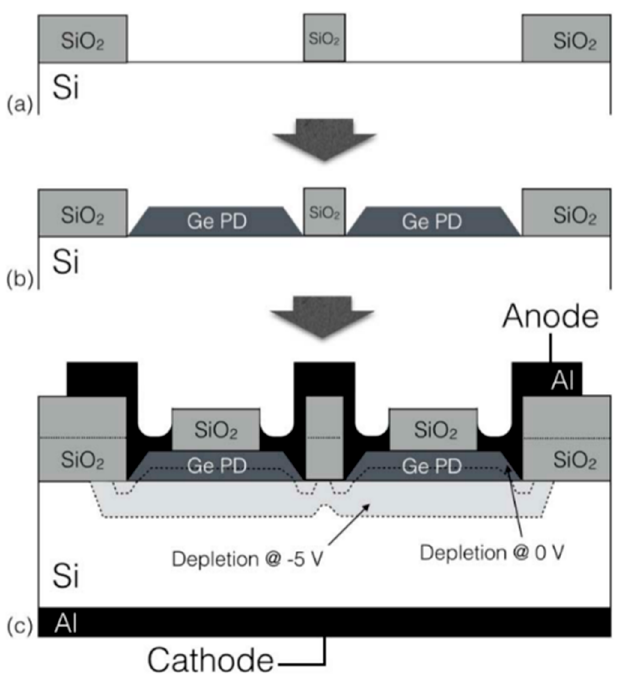
Figure 49. Process flow for PureGaB Ge/Si APDs, ( a ) open the window through SiO 2 to Si, ( b ) deposit the Ge/Si PDs in the windows, ( c ) form the Al contact. Reproduced from [102], IEEE, open access, 2015.